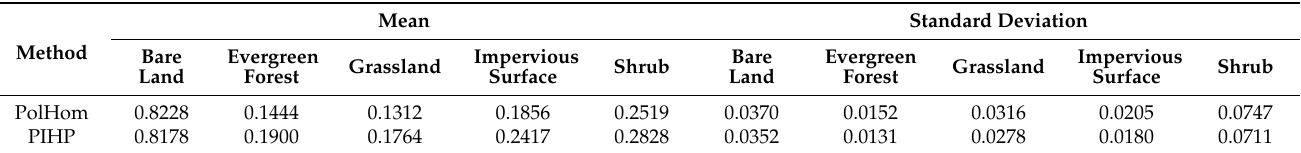
Table 1. Mean and standard deviation of the coherence